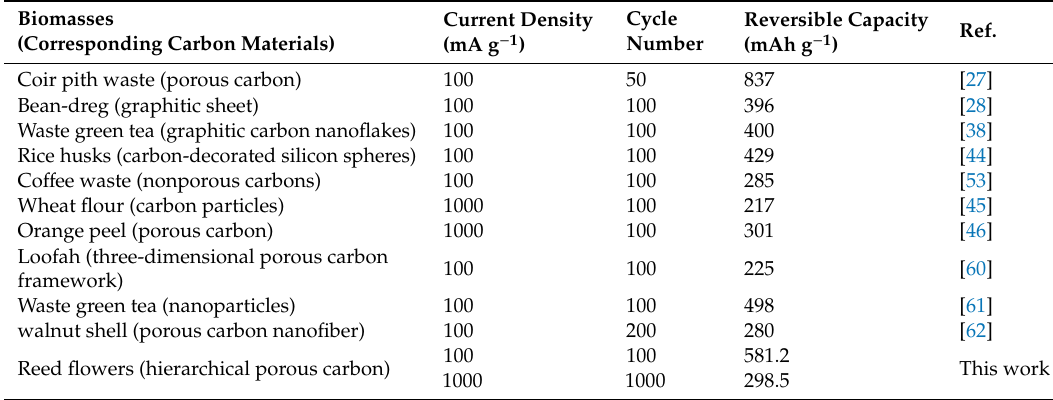
Table 1. Comparison of electrochemical performances for various biomass-derived carbons as LIB